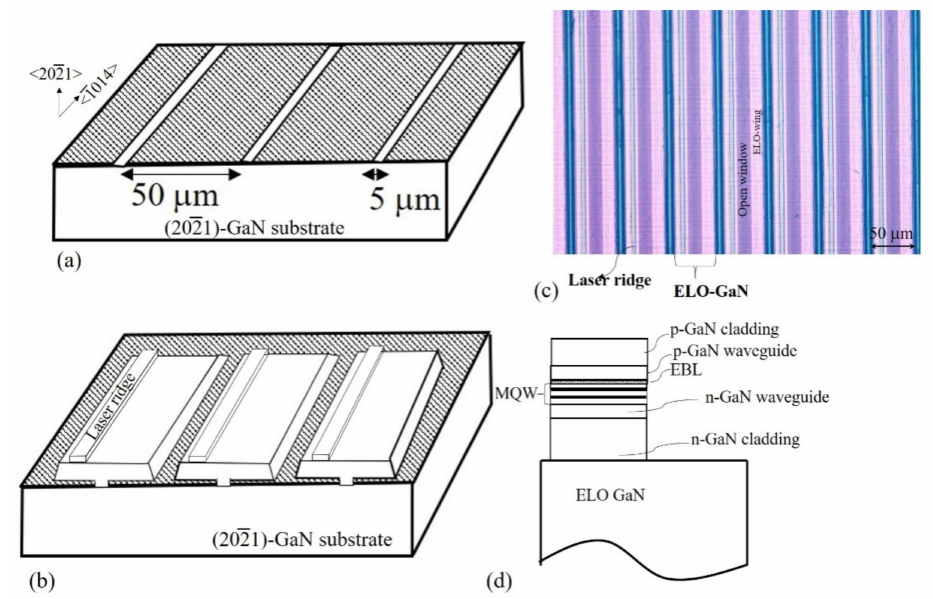
Figure 1. ( a ) SiO 2 mask design on {2021 } semipolar GaN substrate, where open windows are 5 µ m in width and masked portions are 50 µ m in width. ( b ) Bird-view sketch of grown GaN ELO layers from the open window and proposed laser ridge on wing. ( c ) Optical microscope image showing processed LD ridge on ELO wings. ( d ) An illustration showing the laser structure